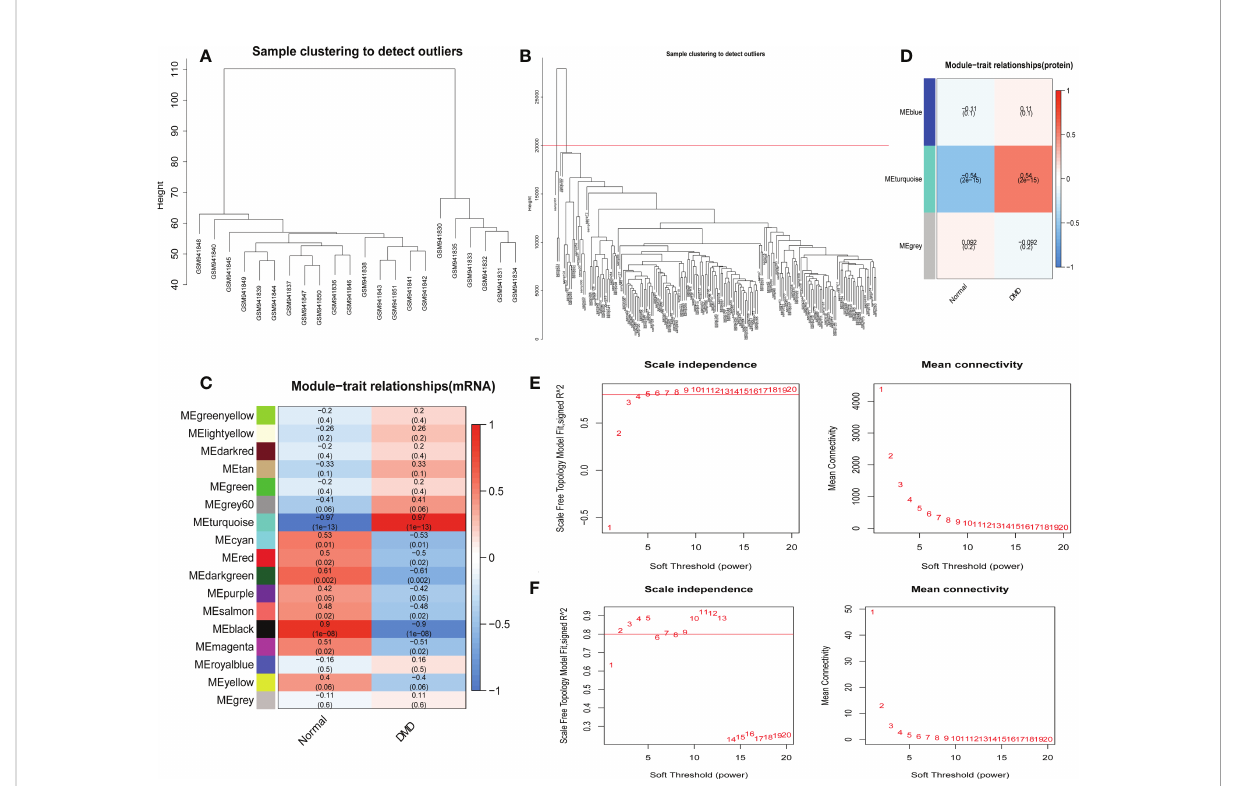
FIGURE 5 Identi fi cation of modules correlated with the clinical phenotype in the GSE38417 and E-MTAB-2564 datasets of DMD. Hierarchical clustering dendrograms of samples in the GSE38417 (A) and E-MTAB-2564 (B) datasets. Module-trait relationship diagrams in the GSE38417 (C) and E- MTAB-2564 (D) datasets. Each row corresponds to a color module and each column corresponds to a clinical trait (DMD or normal). Each cell contains the corresponding correlation and P-value. Analysis of the scale independence and mean connectivity for the optimal soft threshold powers in the GSE38417 (E) and E-MTAB-2564 (F) datasets.